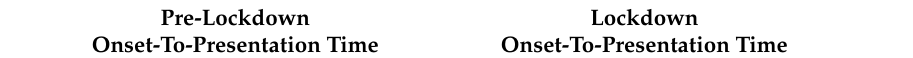
Table 3. Stroke Onset-to-Presentation Time in the Pre-lockdown and Lockdown Cohorts. Median time (in hours) from stroke symptom onset to hospital presentation between the pre-lockdown and lockdown cohorts, with no significant differences identified. p values were generated with Wilcoxon’s signed-rank Test; values <0.05 were deemed statistically significant. ICH: intracerebral haemorrhage, TACI: total anterior circulation infarct, PACI: partial anterior circulation infarct, LACI: lacunar infarct, POCI: posterior circulation infarct: NOS: not otherwise specified, h: hours, IQR: interquartile range, NA: not